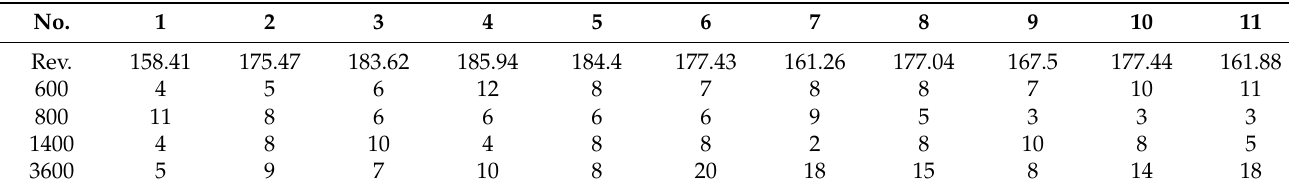
Table 9. Result of SA revenue and bidding